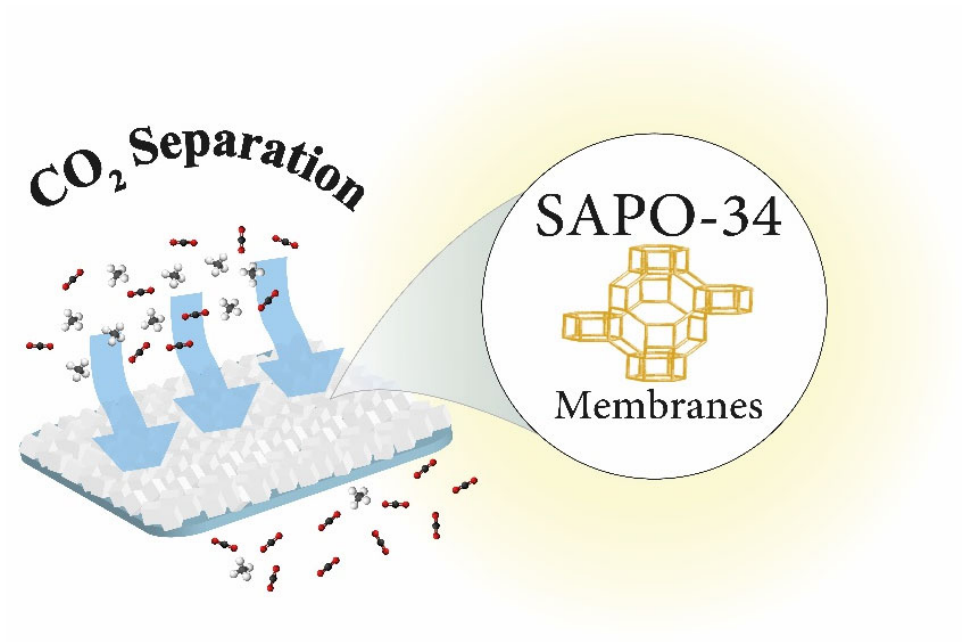
Figure 1. Schematic presentation of SAPO ‐ 34 membranes in CO 2 separation.